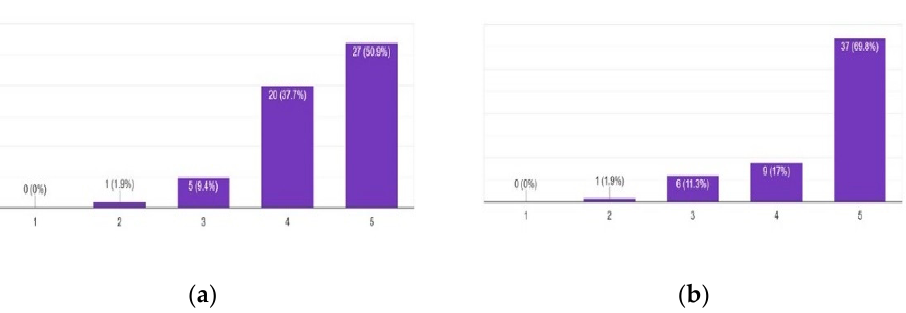
Figure 21. Participants’ opinion: ( a ) the presented activity assists to better understand the objectives of the university’s curriculum; ( b ) similar activities should be added to the university’s curriculum.